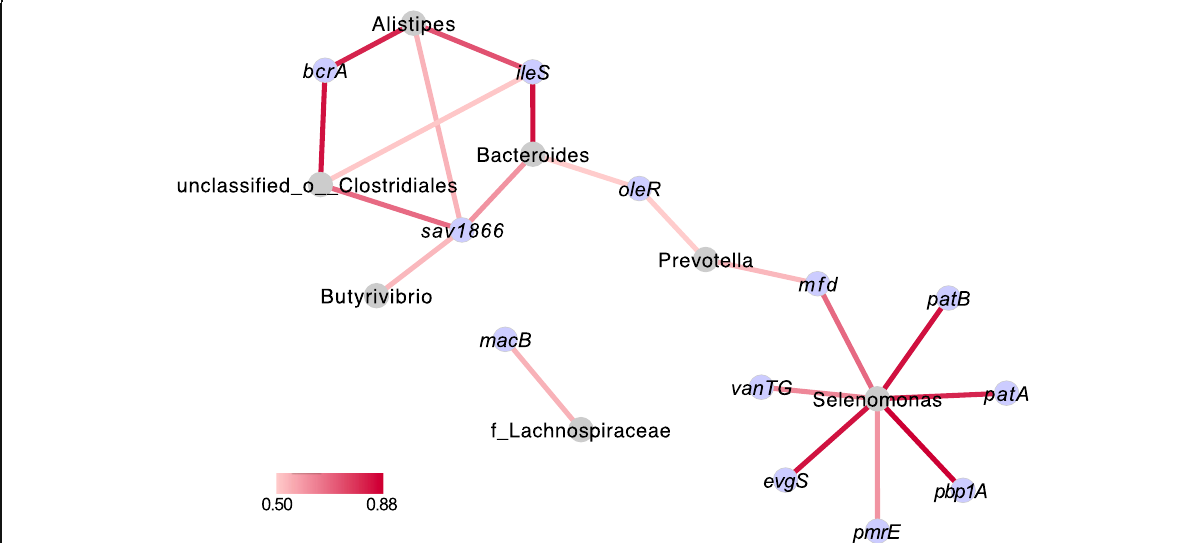
Fig. 7 Co-occurrence network of abundant bacterial genera and ARGs. Abundant bacterial genera (top 10) and ARGs (top 20) of animals in study 2 were selected and used in the co-occurrence analysis. Only strong positive relationships (coefficient> 0.5 and P < 0.05) were displayed in the